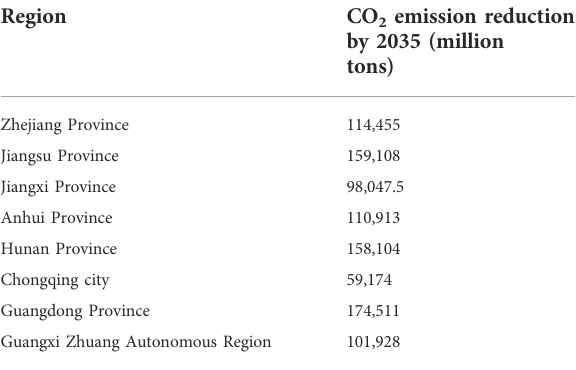
TABLE 9 CO 2 emission reduction after increasing the proportion of geothermal heating in non-central heating provinces and cities.